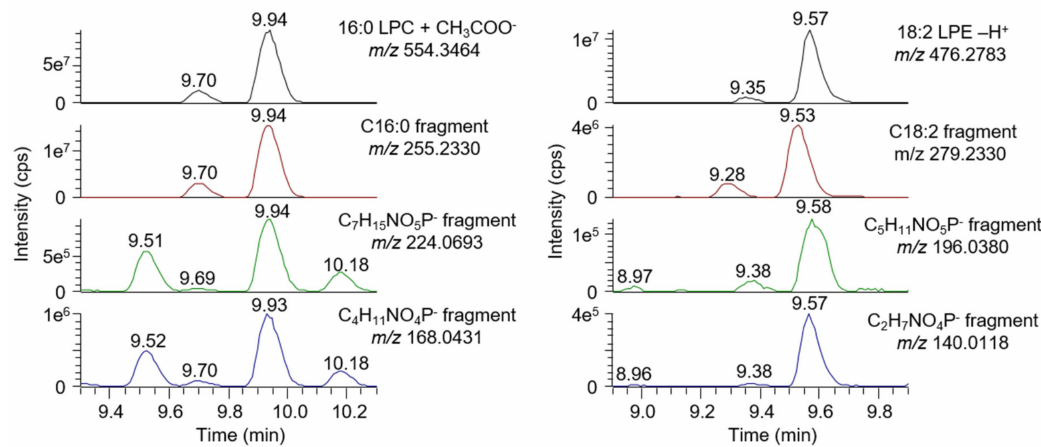
Figure 2. Extracted chromatograms of 16:0 lysophosphatidylcholines (LPC) ( top left ) and 18:2 lysophosphatidylethanol (LPE) ( top right ) in plasma. Two signals corresponding to 2-16:0 LPC (9.94 min) and 1-16:0 LPC (9.70 min) were detected. Fatty acid and head group fragments